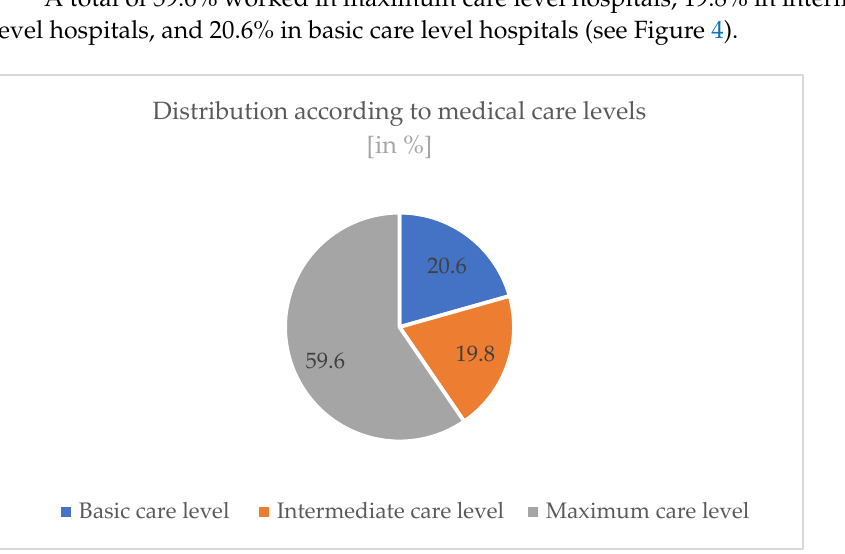
Figure 4. Medical care levels of the participants’ organizations.